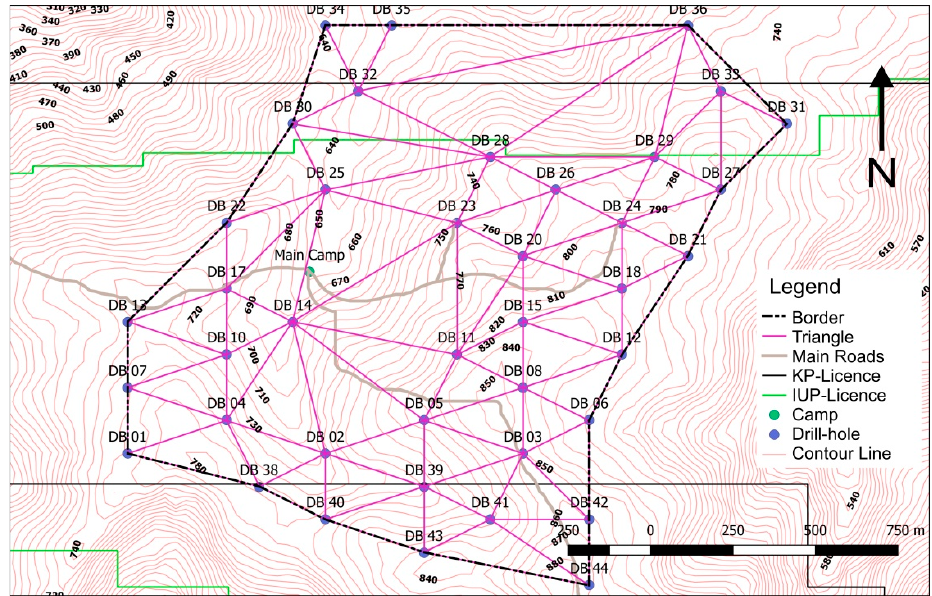
Figure 11. Map of triangles used for Ni and Co resources estimation. Comparison of results of resource estimation by two methods (average abundance method and polygon method) for different cut-off criteria allows to state that differences be- tween results obtained by particular methods characterized by various deposit